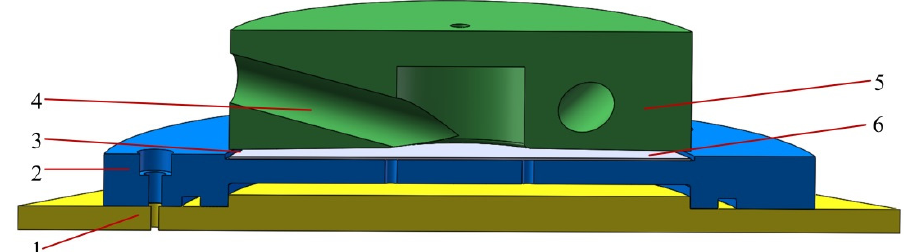
Figure 4. Schematic diagram of precision machining of three-phase abrasive flow: 1. lower fixture, 2. upper fixture, 3. micro-gap, 4. abrasive flow inlet, 5. processing disc, 6. workpiece.